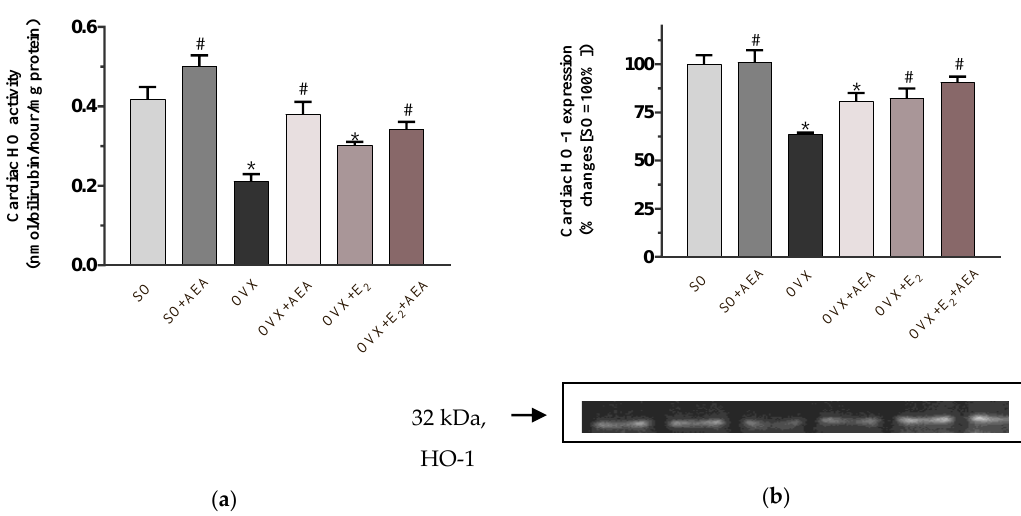
Figure 2. Effects of anandamide and estrogen treatment on cardiac activity and expression of the HO enzyme in SO and OVX animals. ( a ) Cardiac HO activity (expressed as pmol/min/mg protein); results are shown as means ± S.E.M. n = 7–9; ( b ) representative image of cardiac HO-1 expression (expressed as % changes, where SO = 100%); results are shown as means ± S.E.M. n = 5–8; * p < 0.05: statistical significance relative to the SO group, # p < 0.05: statistical significance relative to the OVX group. HO = heme oxygenase, HO-1 = heme oxygenase-1.